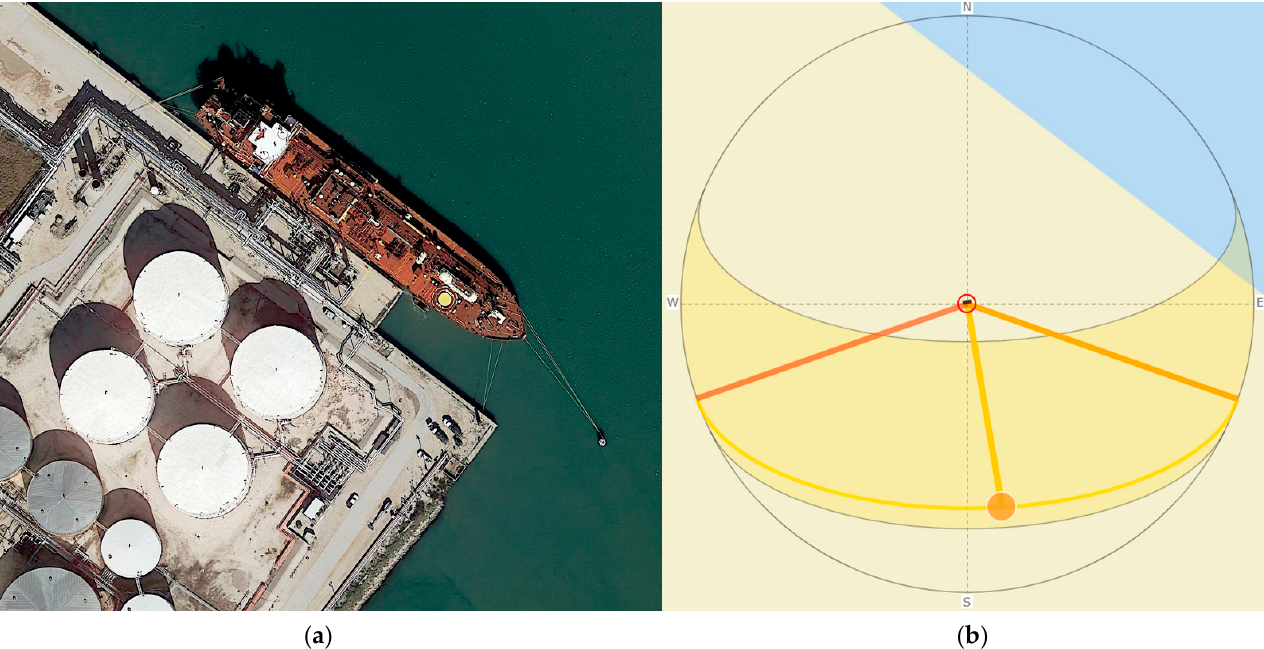
Figure 2. A demonstration of the “sundial” calculation in the Google Earth EO dataset, demonstrat- ing the time of day at which the image was captured: ( a ) a sample image from the Google Earth EO dataset, with visible shadows cast by the ship and circular structures; ( b ) the position of the sun as viewed using the SunCalc.org tool on the corresponding date and location of the image, which is provided by Google Earth. The position of the sun is chosen to correspond to the position of the shadows in the image. For this example, the image was captured near Corpus Christi, TX on 31 January 2020. Using the “sundial” technique, the image was determined to be captured at approxi- mately 12:15 PM local time.